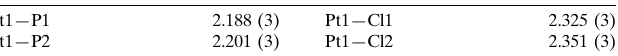
Selected bond lengths (A˚ ).